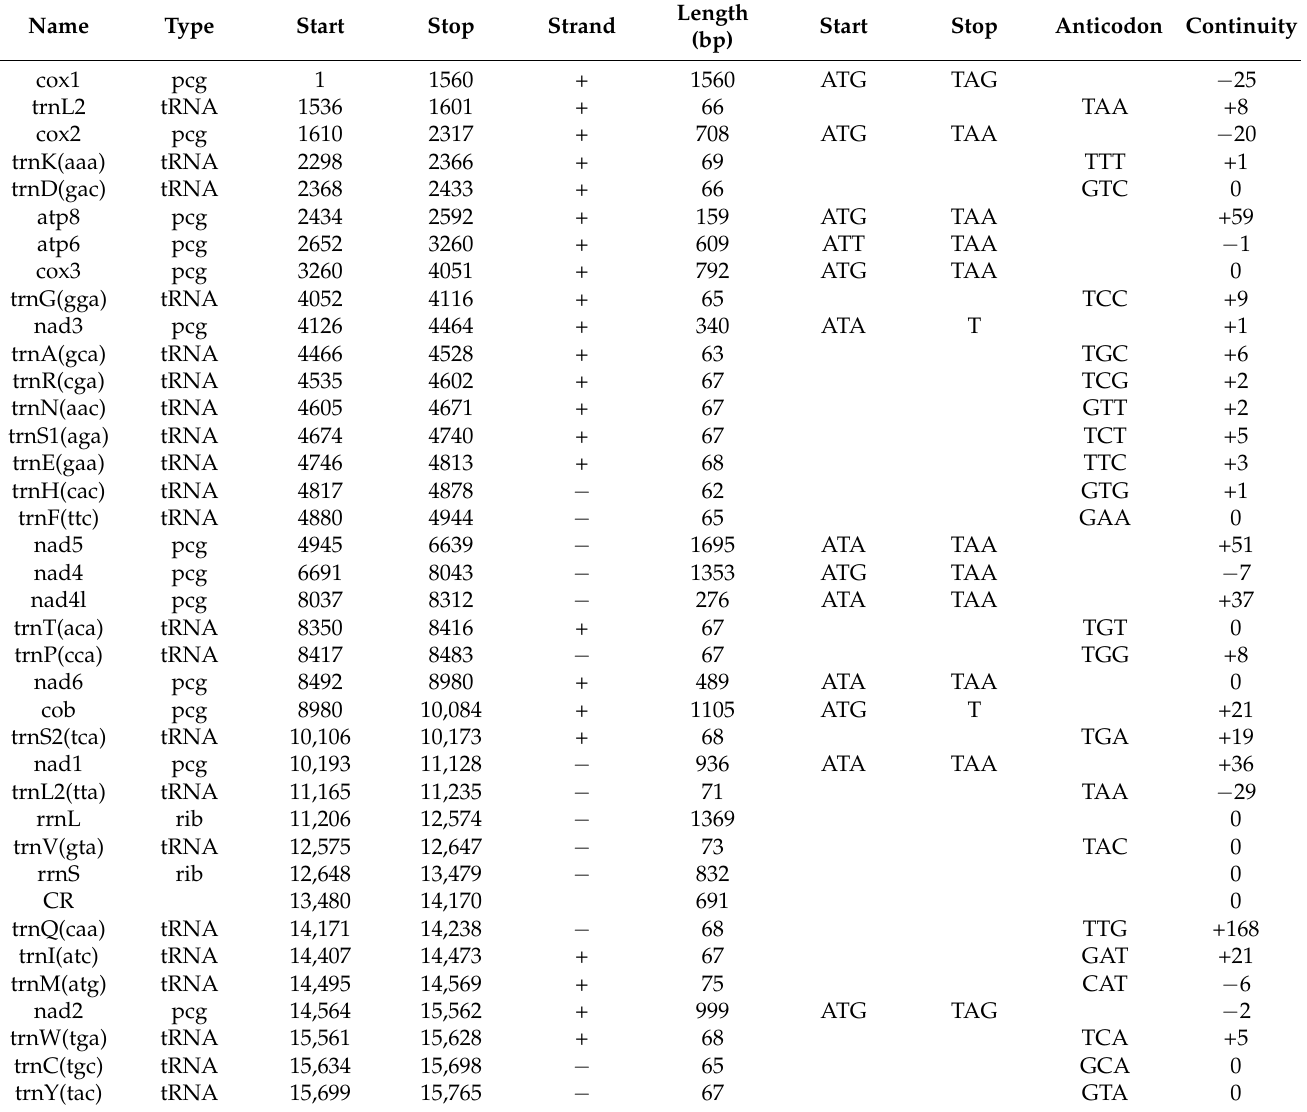
Table 1. Mitochondrial genome of Metopaulias depressus . Arrangement and